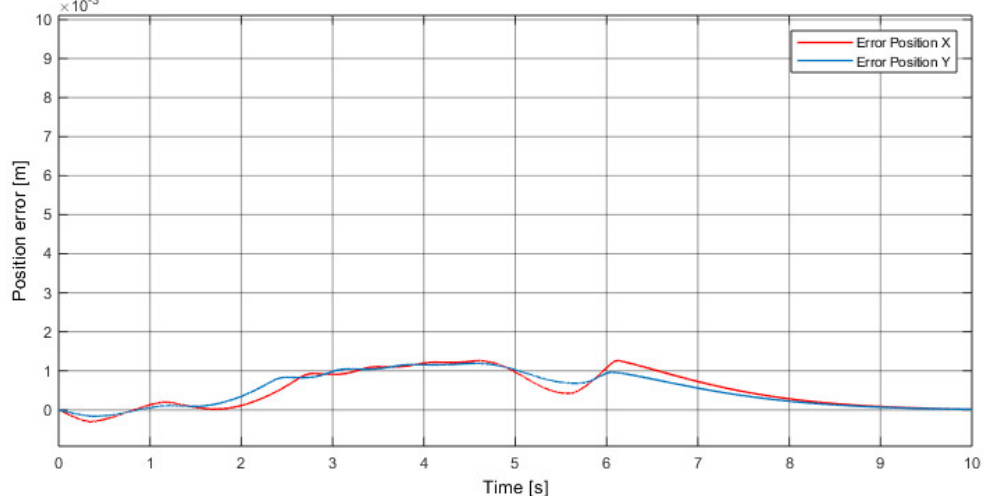
Figure 26. Error signal developed during robot movement under the action of a fuzzy PID control- ler.